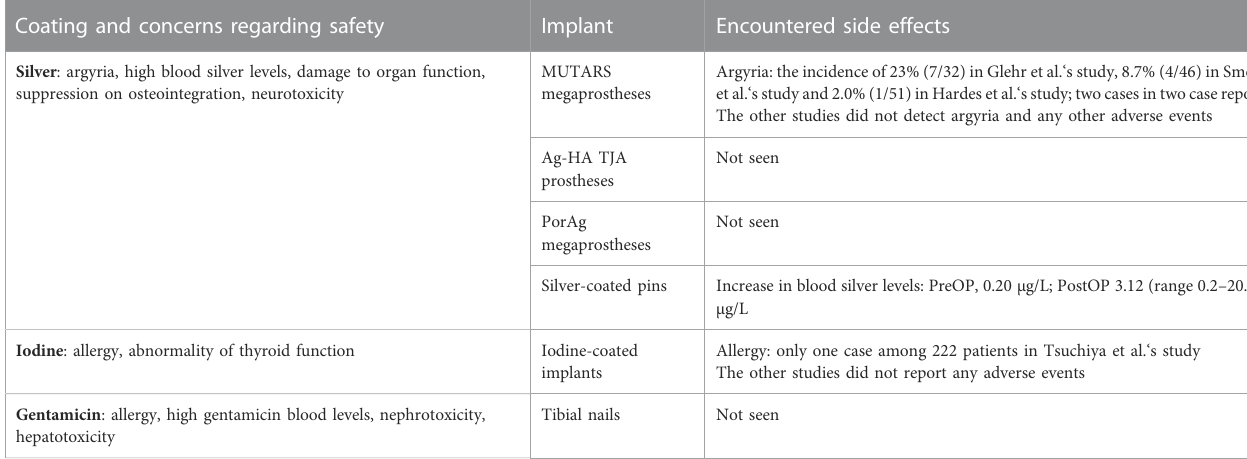
TABLE 2 Reported side effects of antibacterial coatings. Coating and concerns regarding safety Implant Encountered side